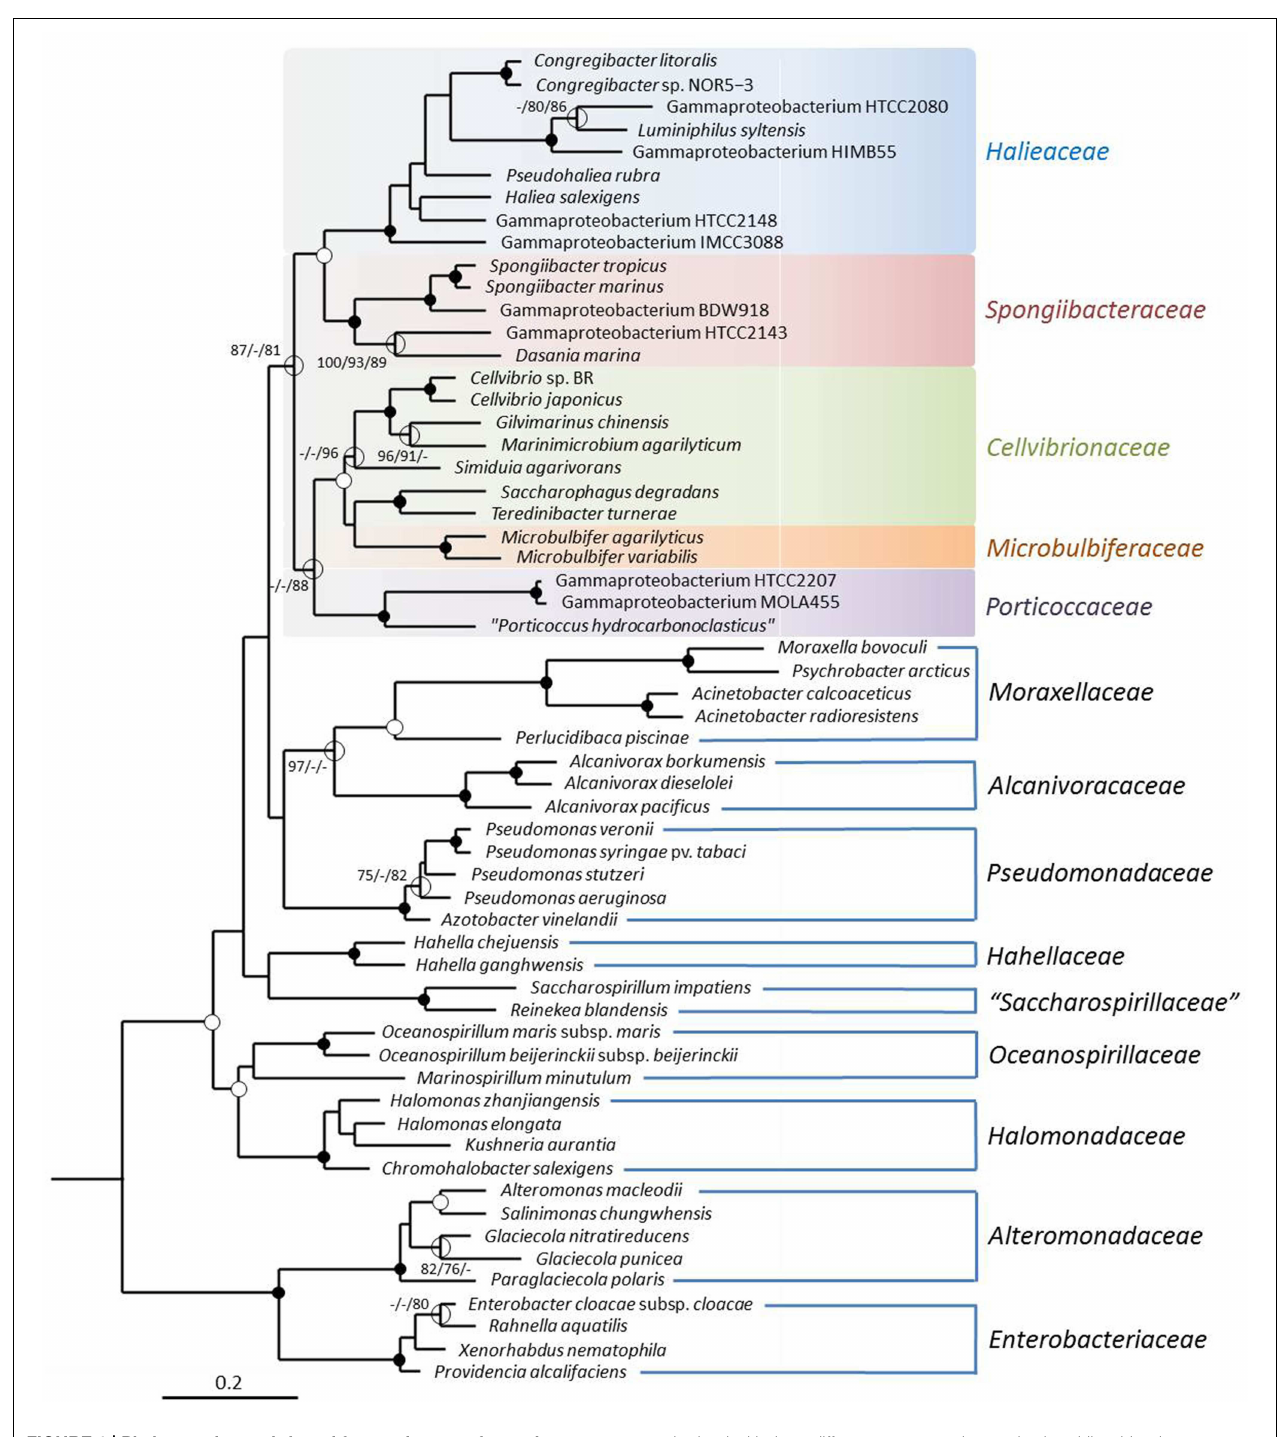
obtained with three different reconstruction methods, while white dots indicate that values of 95% or above were obtained with only two reconstruction methods. Hollow circles indicate that bootstrap values of 75% or above were obtained with at least one reconstruction method. In such cases the values above 75% are given from left to right for the maximum-likelihood, maximum parsimony and neighbor-joining method. The branches are scaled in terms of the expected number of substitutions per